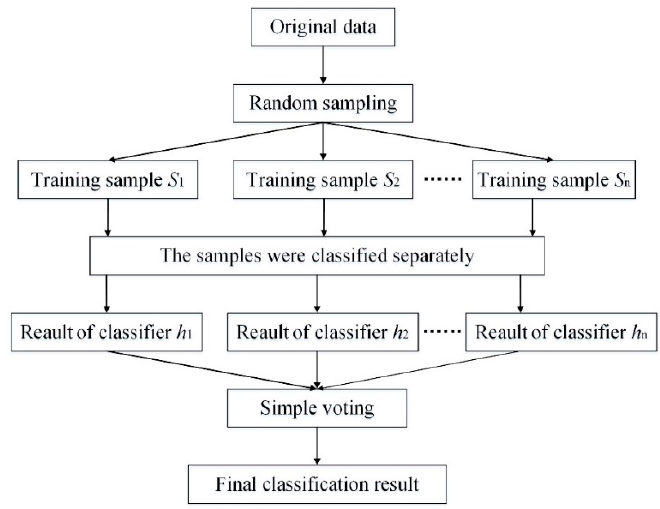
Figure 2. Random forest algorithm